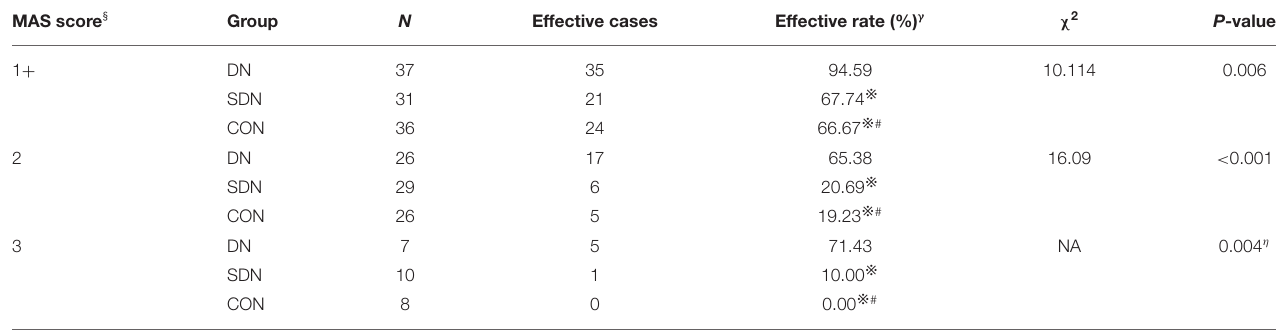
TABLE 6 | Immediate effective rate of wrist spasticity relief in patients with different degree of spasticity. MAS score § Group